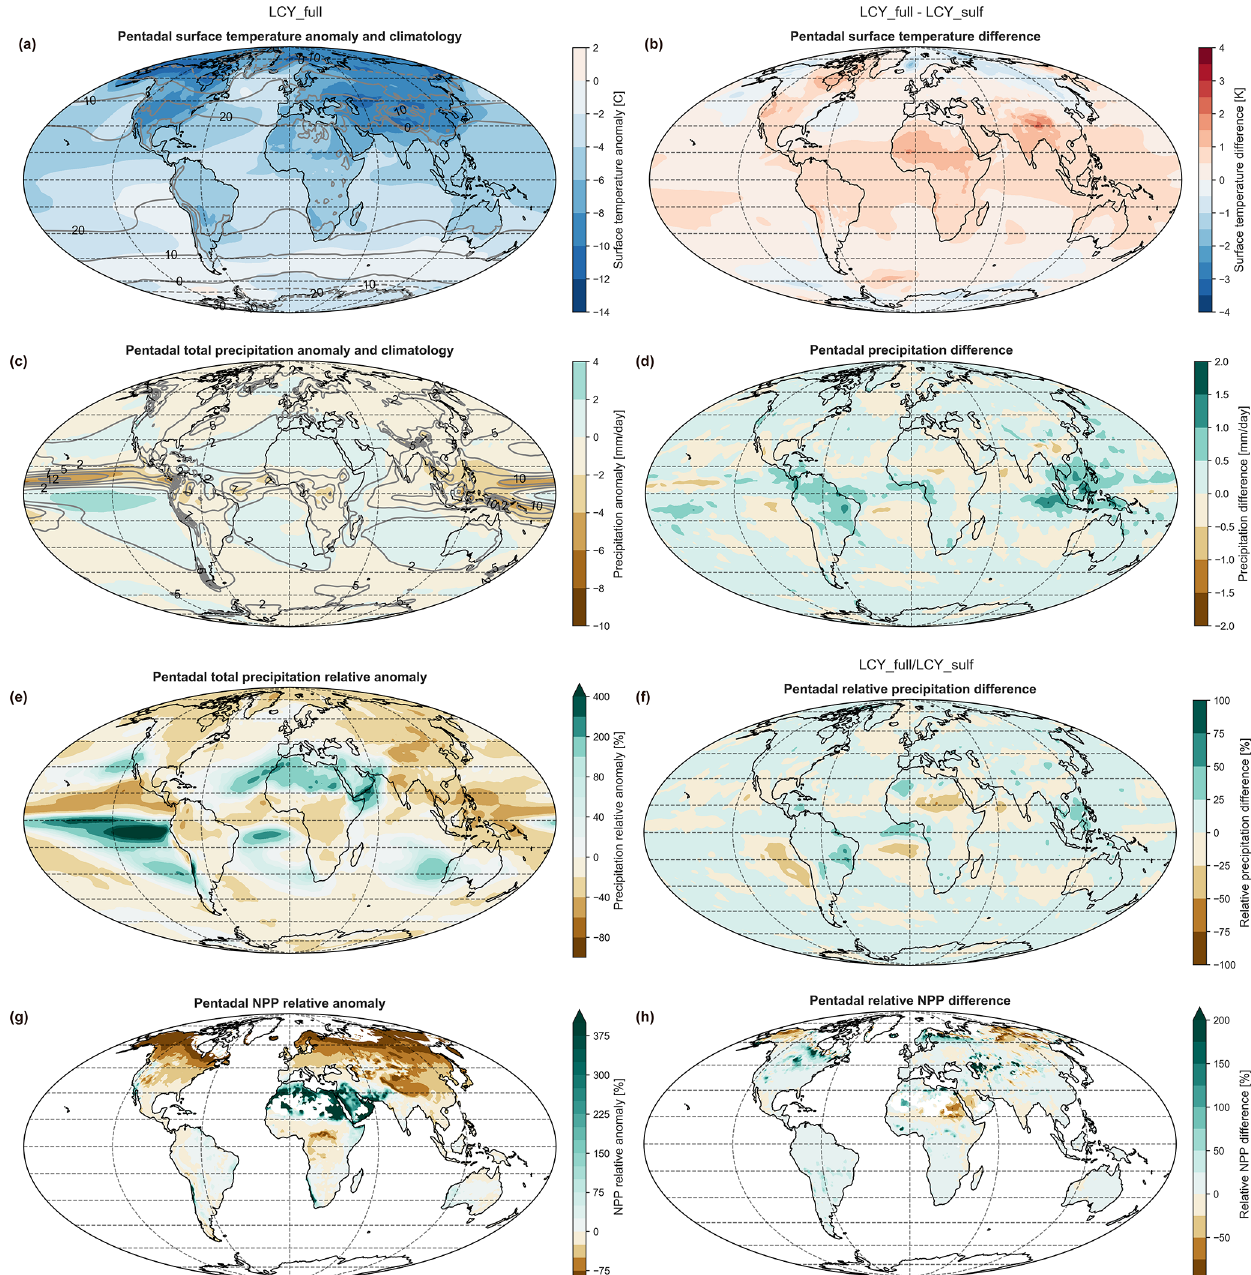
Figure 5. Maps of post-eruption 5-year (pentadal) means for LCY_full with climatology (a, c, e, g) and the differences between LCY_full and LCY_sulf (b, d, f, h) as follows: surface temperature anomaly (a, b) , precipitation anomaly (c, d) , relative precipitation anomaly (e, f) , and relative net primary production (NPP) anomaly (g, h) . White areas on the NPP maps indicate invalid